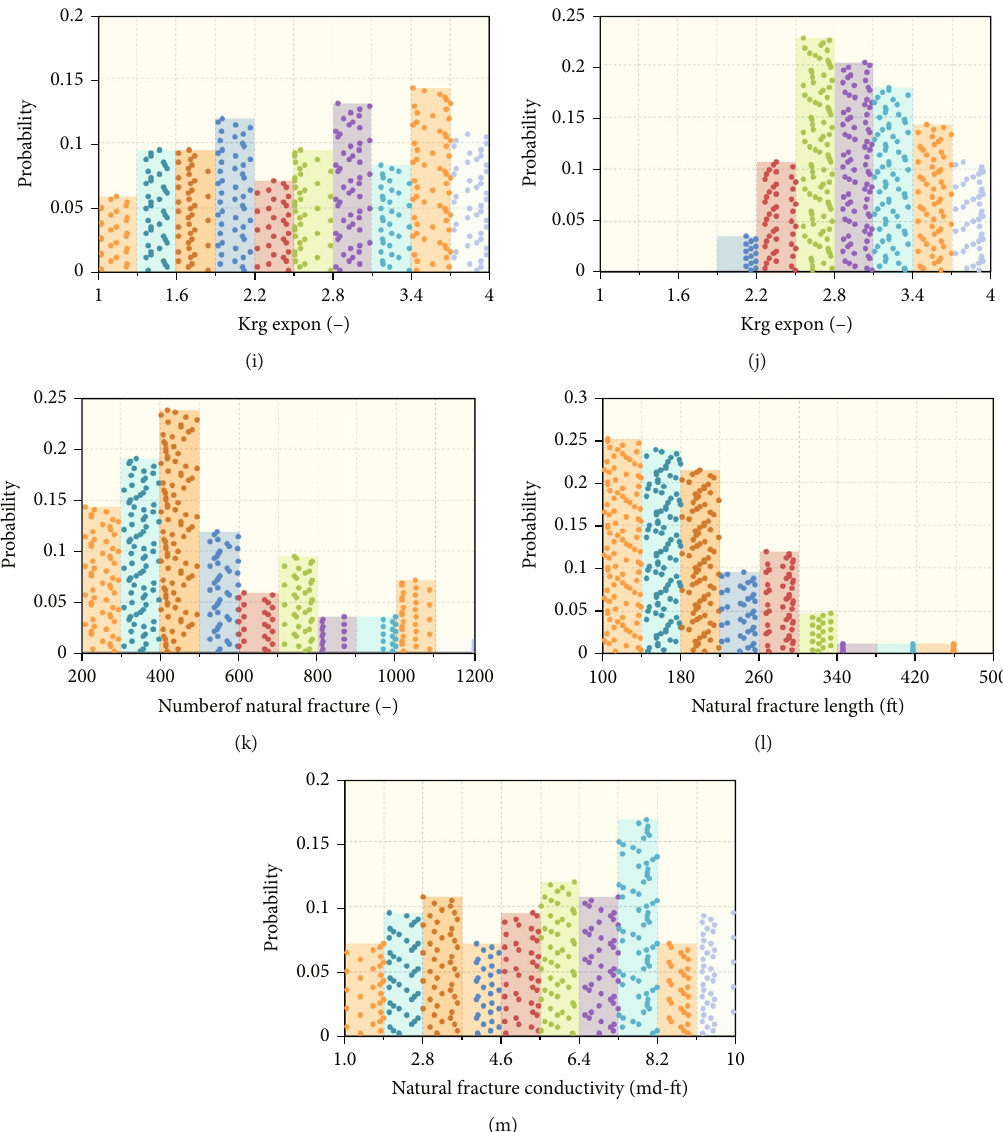
Figure 4: Histogram of posterior vs. prior distributions of 13 uncertain parameters: (a) matrix permeability, (b) fracture height, (c) fracture half-length, (d) fracture water saturation, (e) fracture width, (f) fracture conductivity, (g) matrix porosity, (h) the endpoint of water relative permeability, (i) the exponent of gas relative permeability, (j) the exponent of water relative permeability, (k) number of natural fracture, (l) natural fracture length, and (m) natural fracture